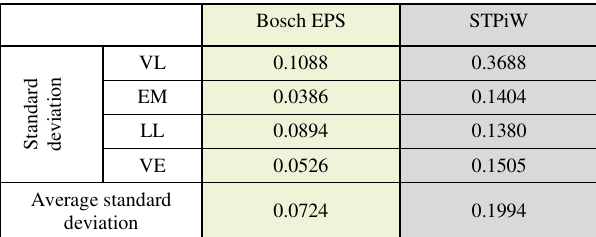
Table 3. Standard deviations of measurements